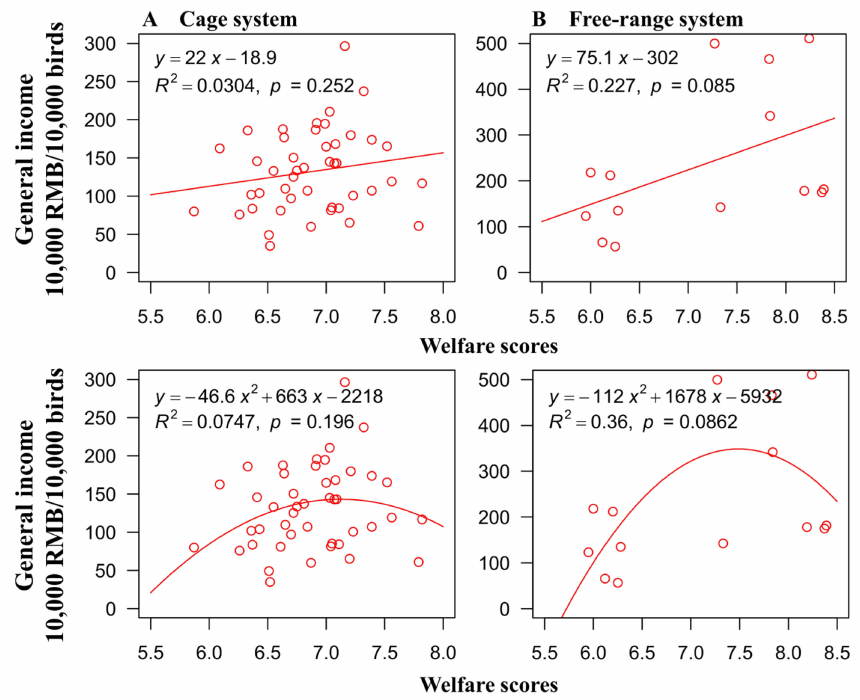
Figure 9. Regression model for a relationship between general income of cage ( A ) and free-range ( B ) egg production and overall animal welfare score.